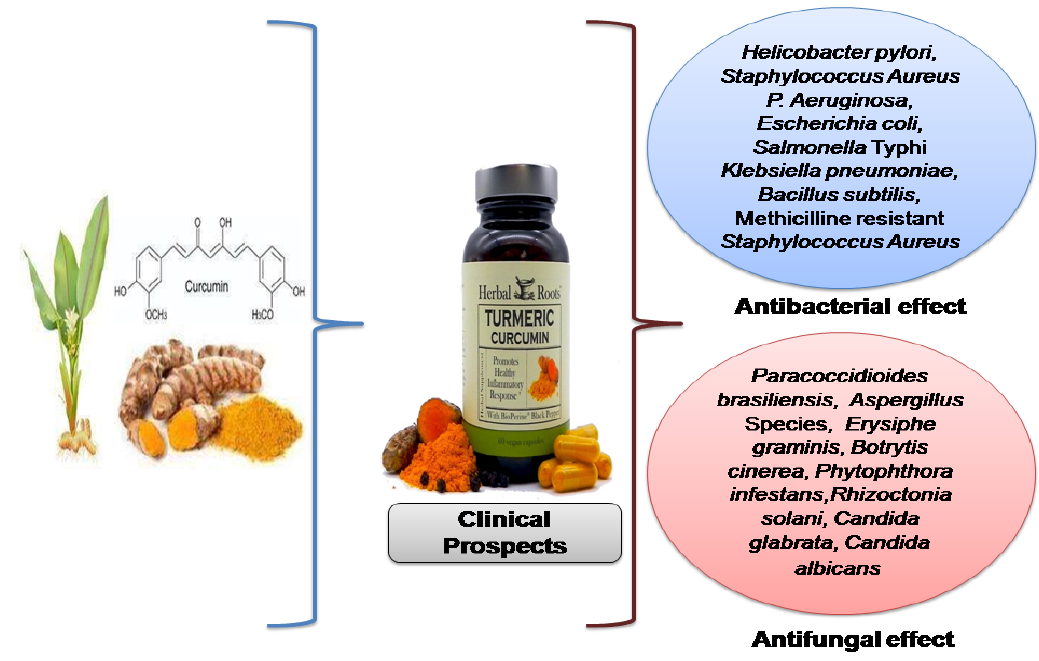
Figure 2. Anti-microbial spectrum of curcumin.